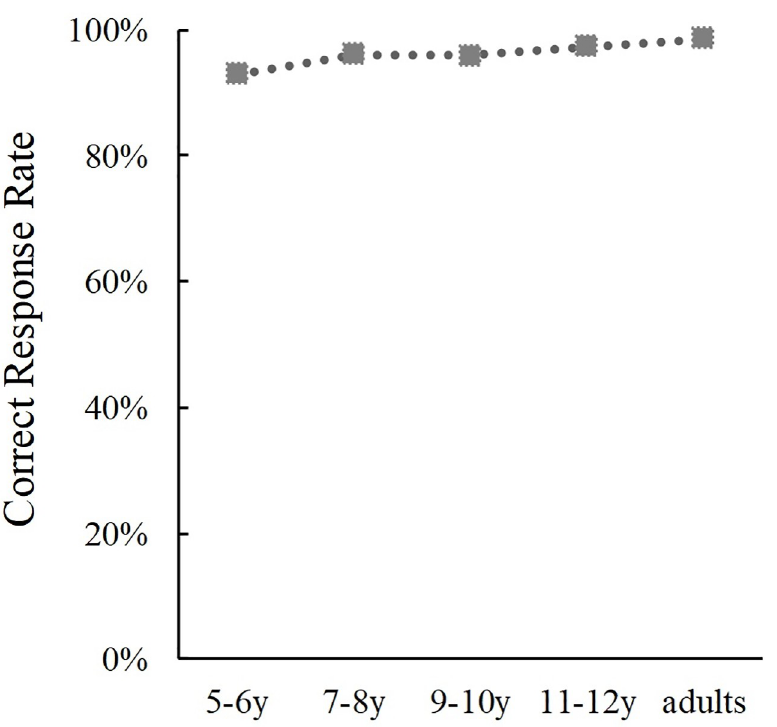
Fig 6. Developmental changes in correct response rates in the phoneme perception